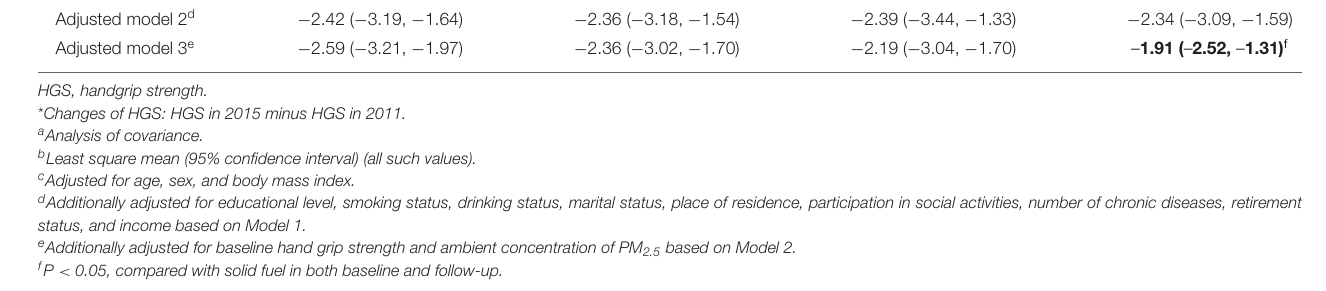
Persisting solid fuel Switching solid fuel to users clean fuel users